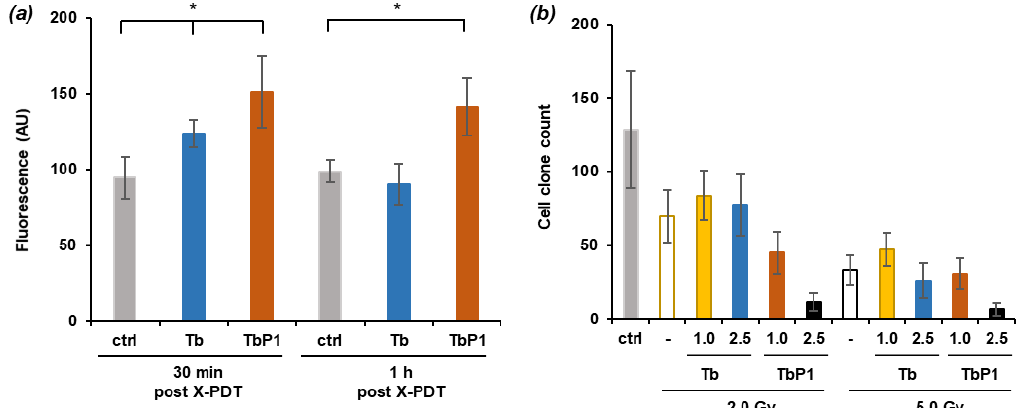
Figure 6. Effect of X-PDT on U-251 MG cell survival and reactive species content. ( a ) U-251 MG cells pre-treated with nanoparticles were exposed to X-ray irradiation at 2.0 Gy (320 kVp), then incubated with 50 µM DCF2-DA. The cells were harvested, and reactive species were quantified by flow cytometry. Results are means ± S.D of triplicate determination from three independent experiments. * p < 0.05 (Kruskal-Wallis test and post-hoc by the Dunn’s test), comparison between nanoparticles-treated and -untreated cells (ctrl, control). ( b ), U-251 MG cells were treated with 1.0 or 2.5 µM P1 equivalent concentration of AGuIX@Tb-P1 (TbP1) and corresponding AGuIX@Tb (Tb) concentration, respectively, 16.6 or 45.1 µM